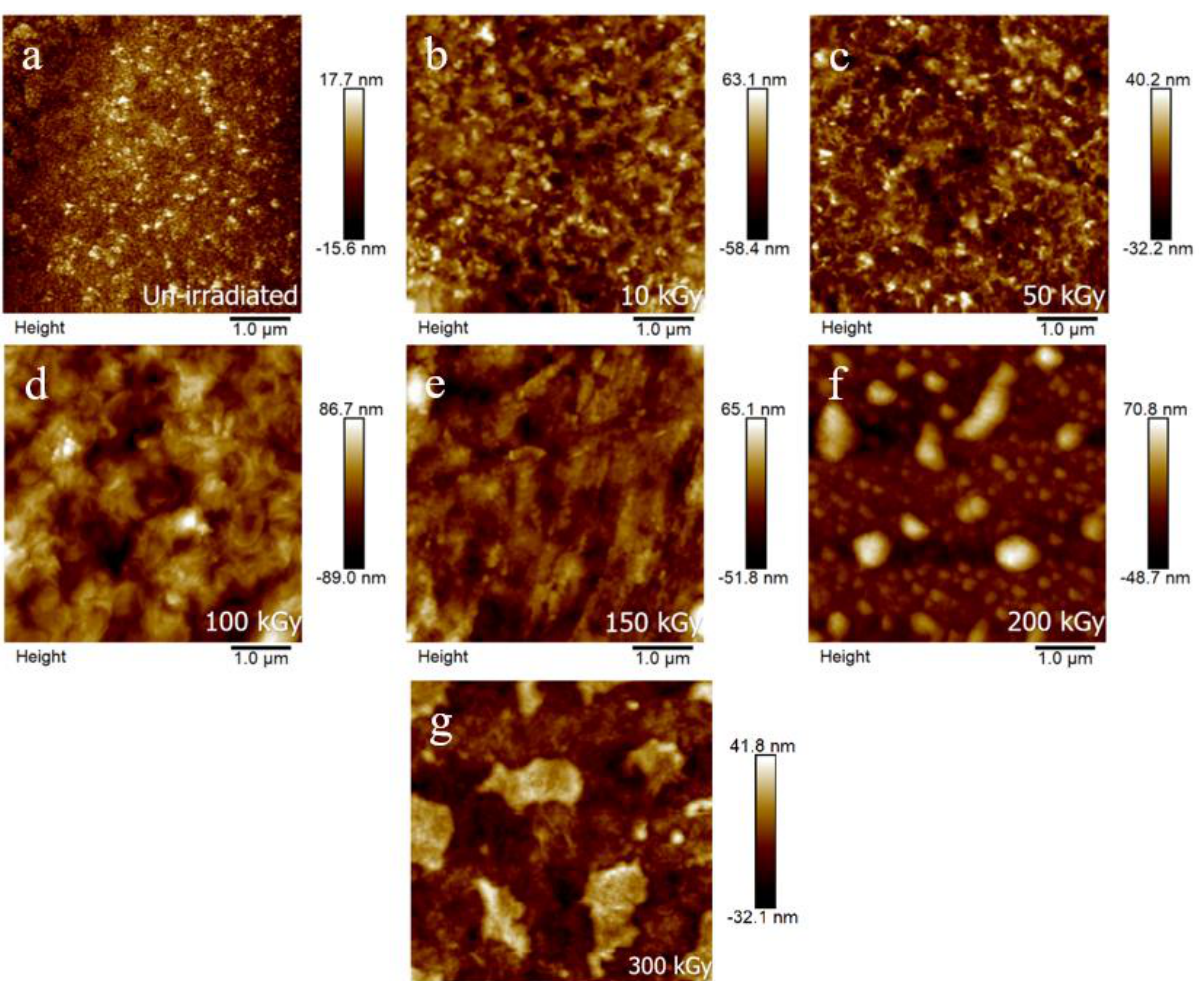
Figure 5. AFM images of ZnO with increasing TID; ( a ) Unirradiated, ( b ) 10 kGy, ( c ) 50 kGy, ( d ) 100 kGy, ( e ) 150 kGy, ( f ) 200 kGy, ( g ) 300 kGy.